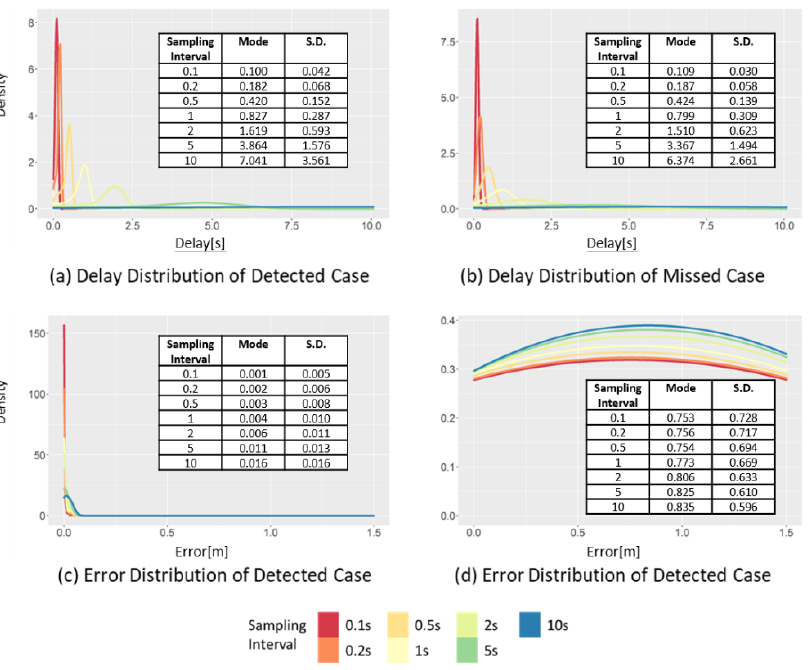
Figure 12. Changes in the delay and error distribution of the LPV in detected case and missed case, varying the sampling intervals.